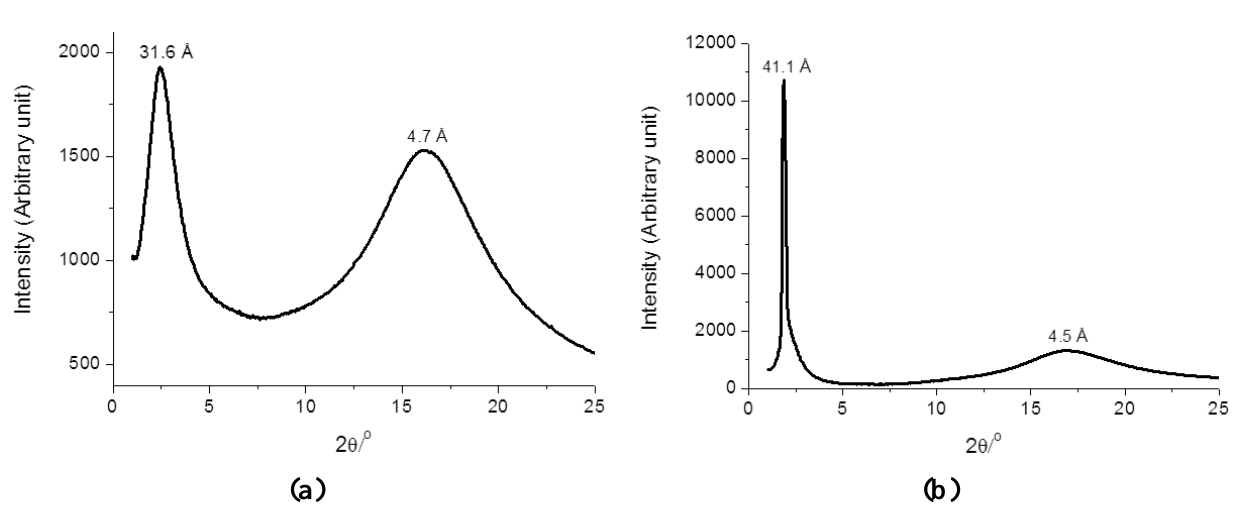
Figure 4. XRD patterns of trifluoro compound 9 : ( a ) the N phase at 130 °C and ( b ) the smectic C (Sm C ) phase at 55